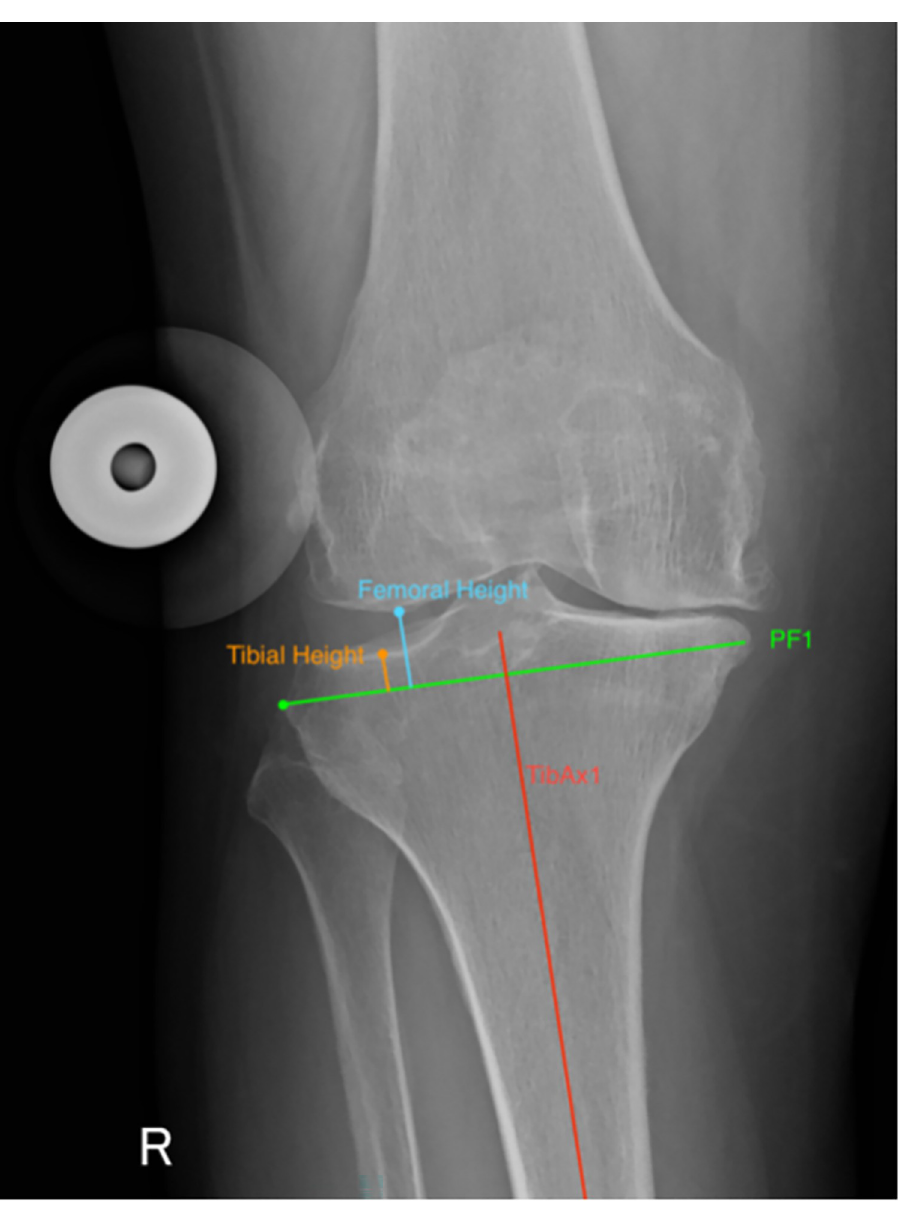
Fig 1. Pre-operative IJLCM technique. Assessment of pre-operative joint line height calculated as the average value of the tibial height and femoral height on the least affected side. TibAx1 = the intramedullary axis of the tibia , PF1 = a line perpendicular to TibAx1 at the level of the most proximal point of the proximal fibula . https://doi.org/10.1371/journal.pone.0272722.g001 PLOS ONE | https://doi.org/10.1371/journal.pone.0272722 August 25,